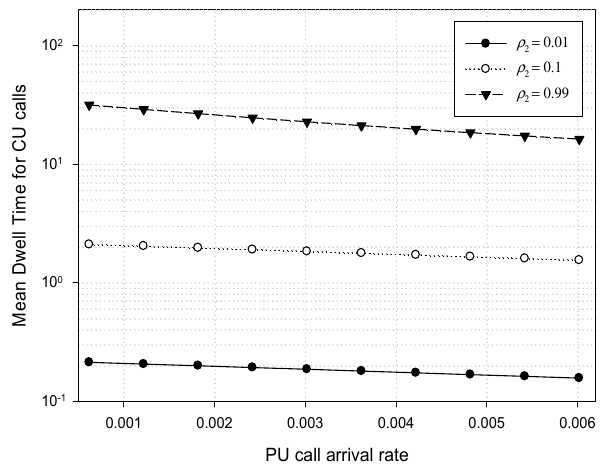
Figure 7. Mean dwell time for CU calls.